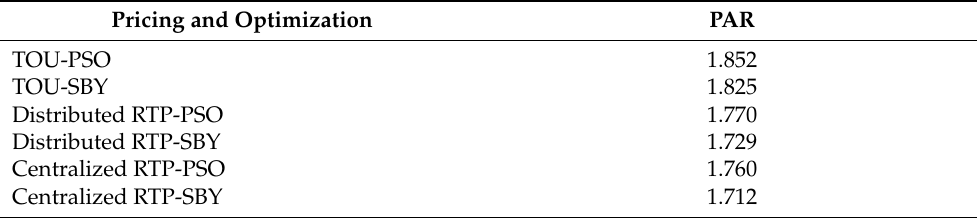
Table 9. PAR calculation for the residential